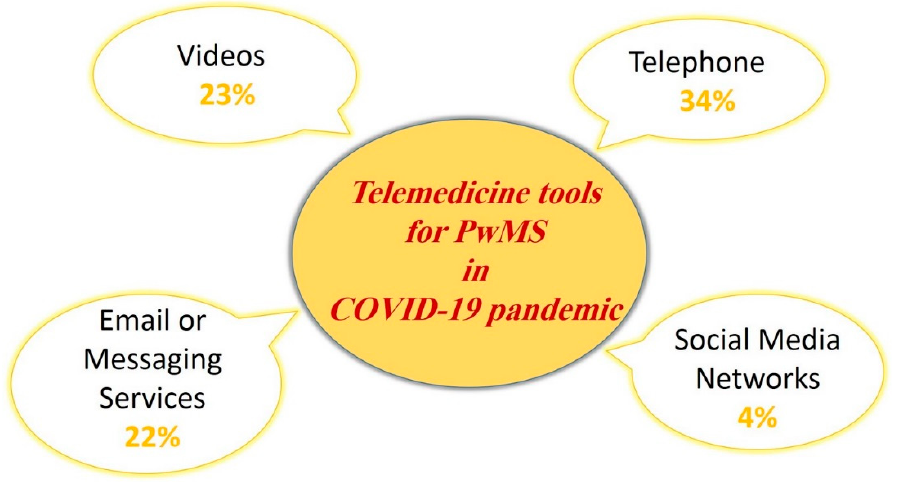
Figure 4. Utility of telemedicine as the care management tool for patients with MS (PwMS) in the COVID-19 era. The percentages were extracted from the ECTRIMS study [63].